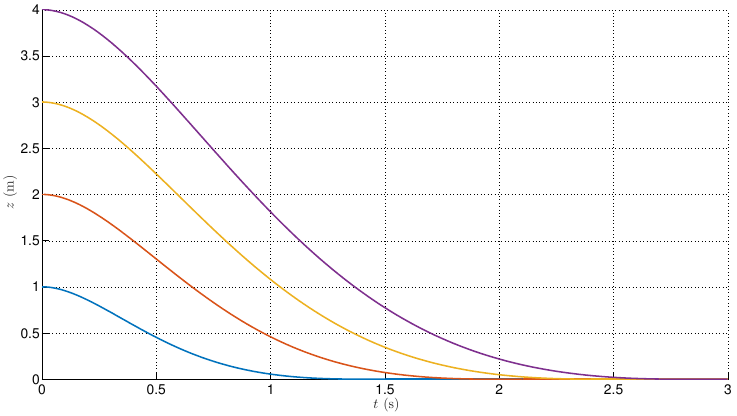
Figure 6. Minimum-energy landing trajectories (for various initial altitudes—see the values at t =